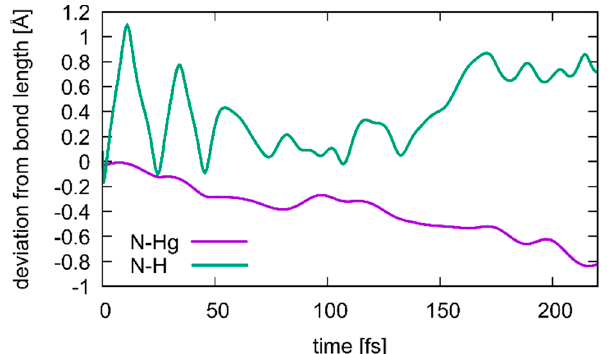
Figure 10. Changes in the N3···H (green) and N3···Hg2 (purple) distances during transition from